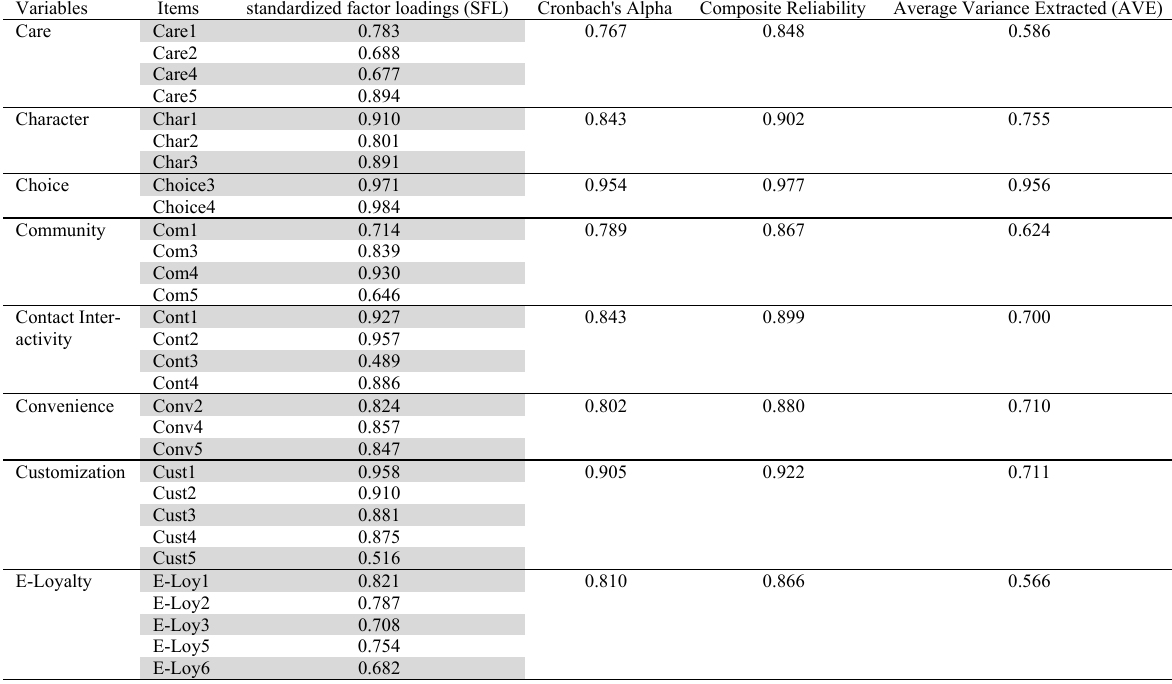
Results of reliability and validity